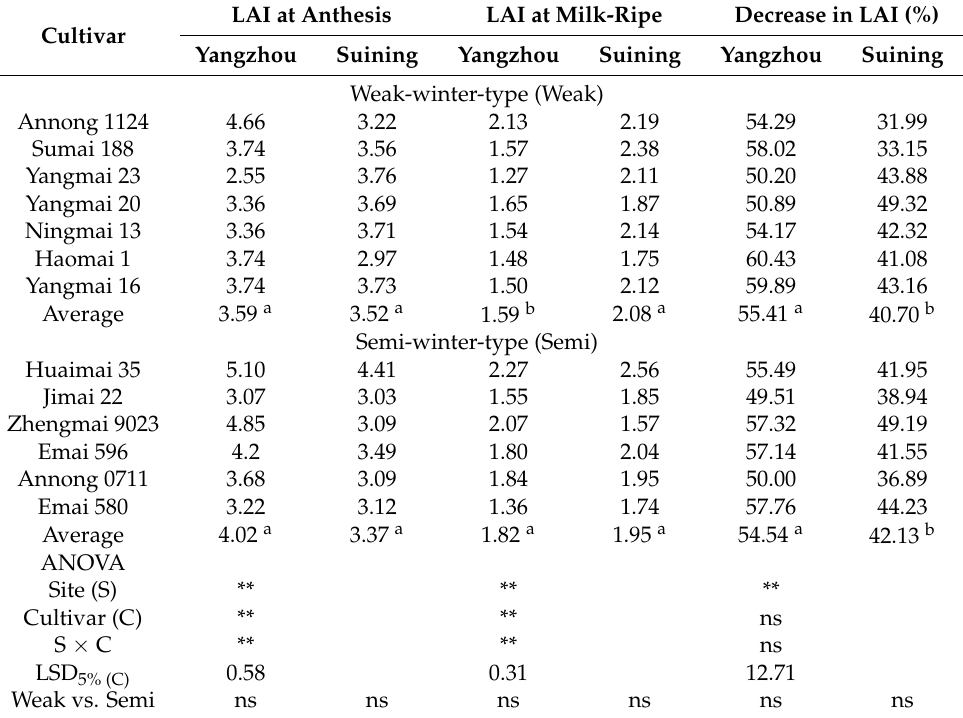
Table 7. Leaf area index (LAI) and decrease in LAI of weak-winter-type and semi-winter-type cultivars planted in southern (Yangzhou) and northern (Suining) areas of the Yangtze River basin, China, in